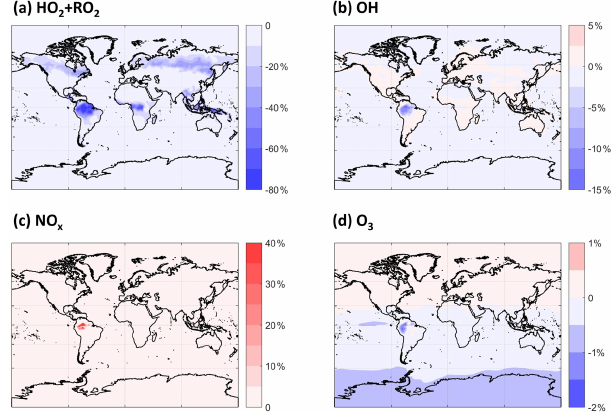
Figure 6. The annual PBL-averaged relative differences in (a) HO 2 + RO 2 , (b) OH, (c) NO x , and (d) O 3 between the Low- Prod_Photo and Default